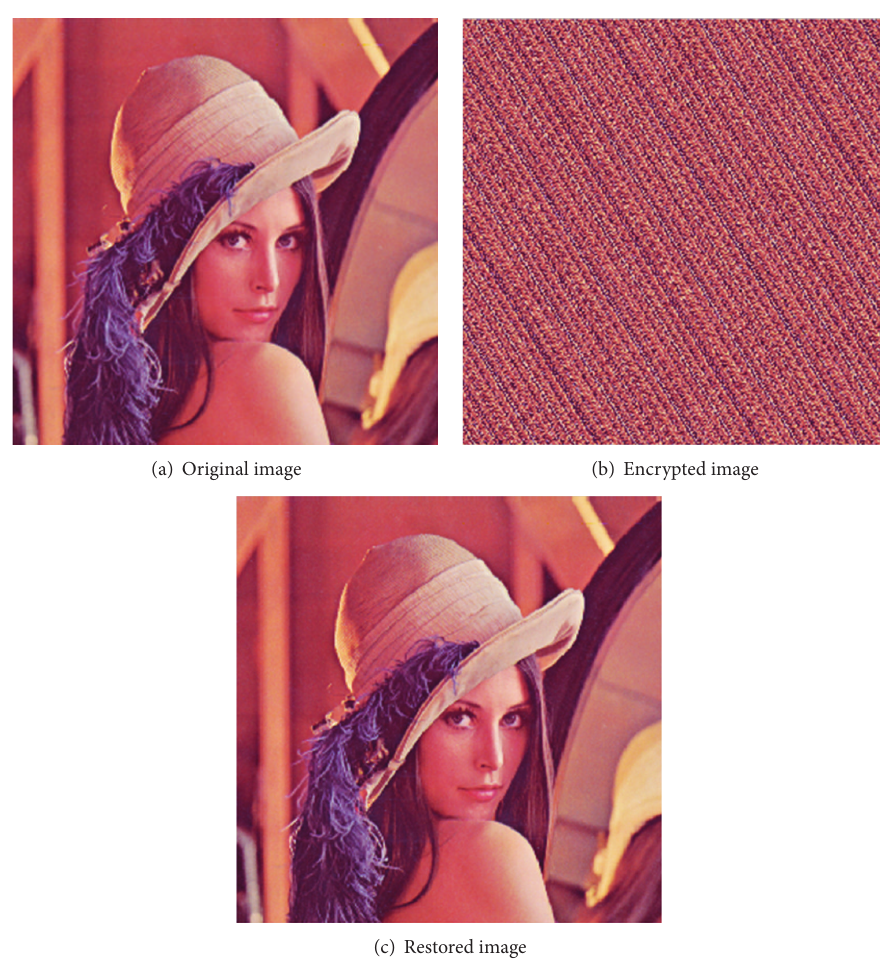
Figure 3: Arnold Transform as image/video frame encryption